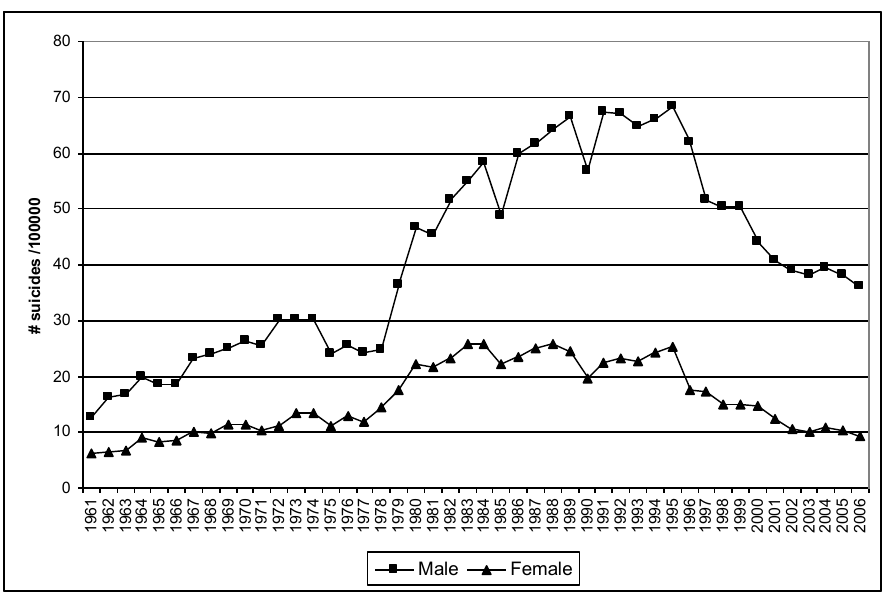
Figure 2 Suicide rates in Sri Lanka by Sex since 1961to 2006